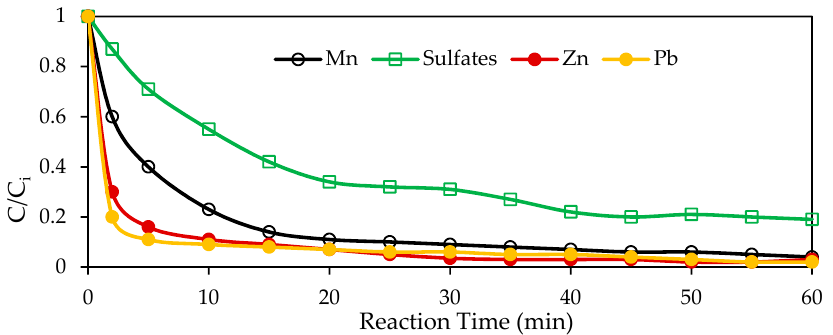
Figure 2. Removal of heavy metals from a mixture of acid mine drainage and pharmaceutical- containing wastewater at an initial pH of 5.6, using nano zero-valent iron (nZVI).